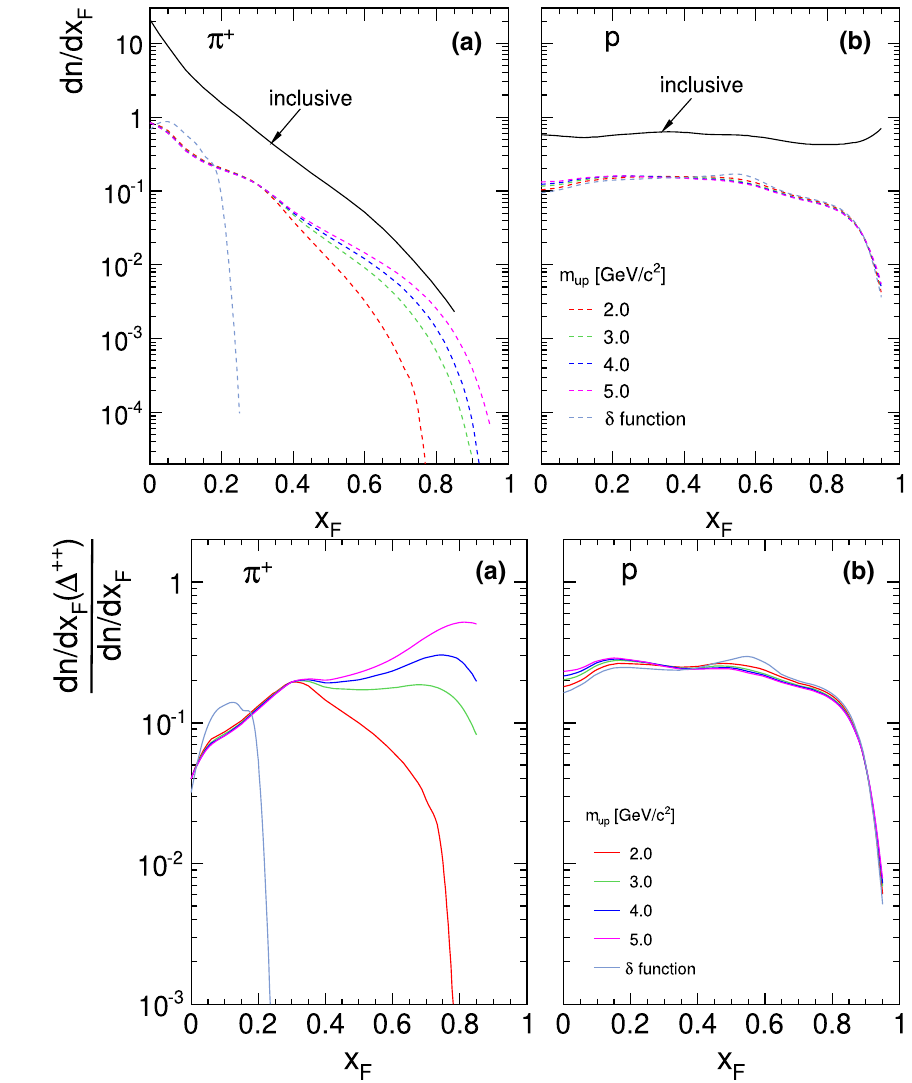
Fig. 167 dn / dx F distributions from Δ ++ decay as a function of x F for different damping factors f supp ( m ) at √ s = 17.2 GeV, a for decay pions, b for decay protons. The respective measured inclusive cross sections are indicated as full lines